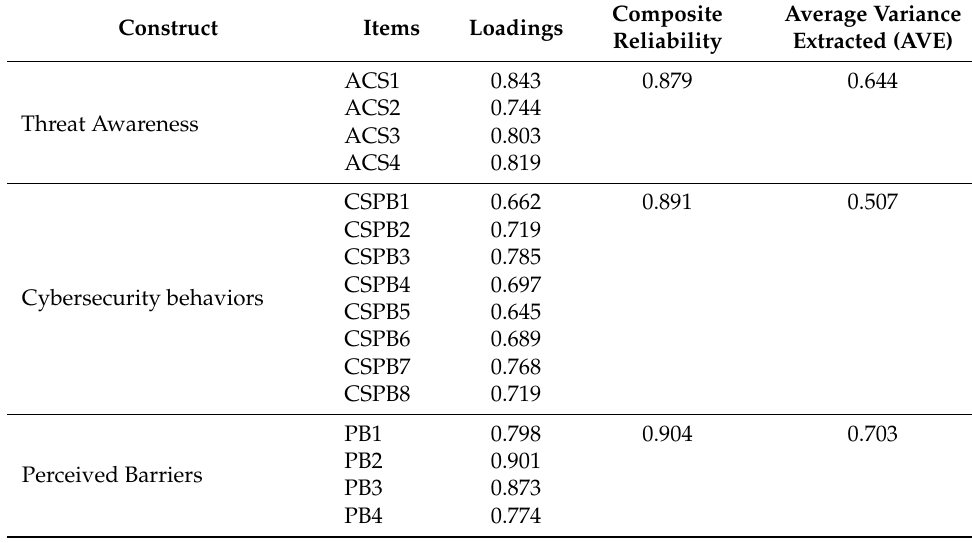
Table 3. Reliability and validity